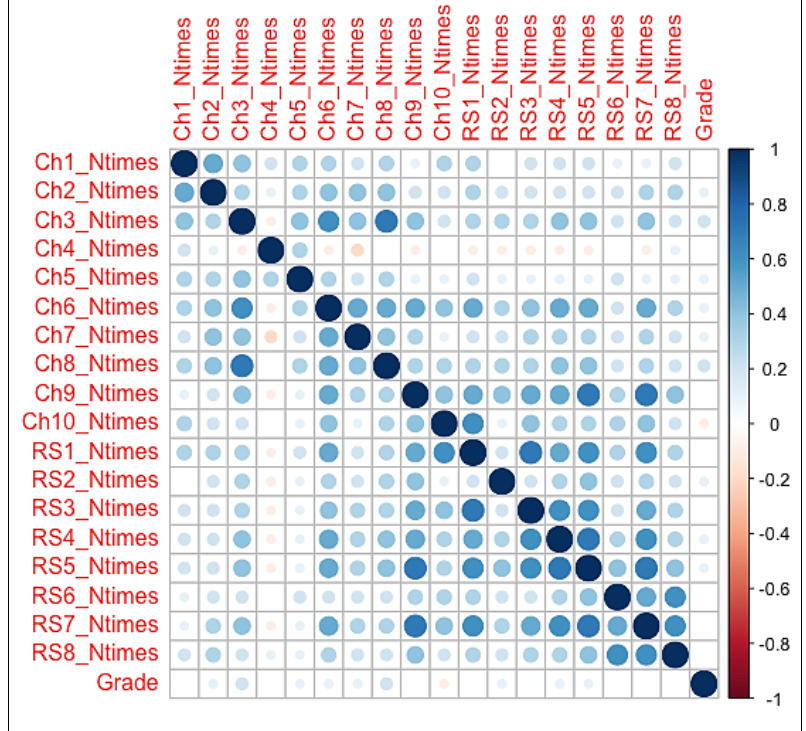
Figure 5. Correlation plot for study chapters and final grade.